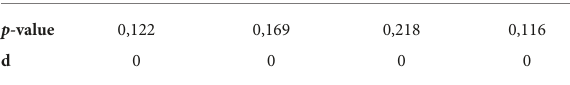
TABLE 6 P -value and d of the O 2 Hb and HHb signals in the two epochs before and after. O 2 Hb before O 2 Hb after HHb before HHb